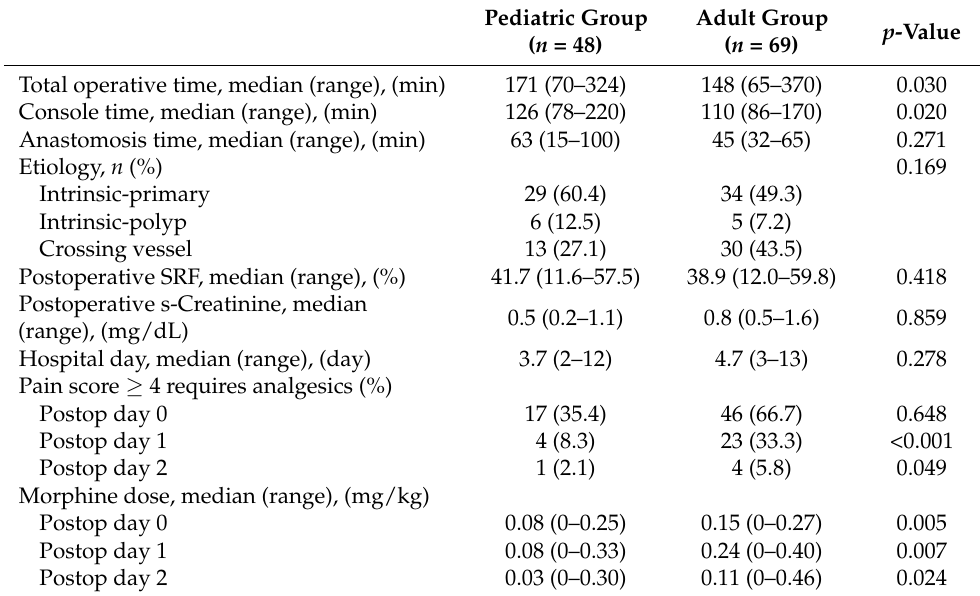
Table 2. Perioperative and postoperative outcomes according to